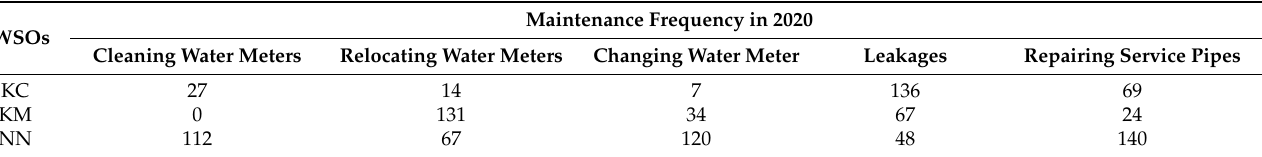
Table 6. Maintenance frequency of water distribution networks in